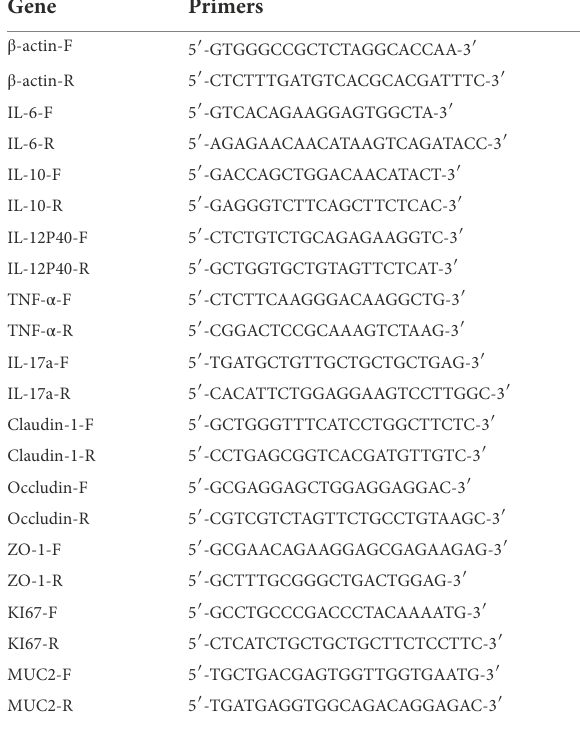
TABLE 1 Primers sequences for